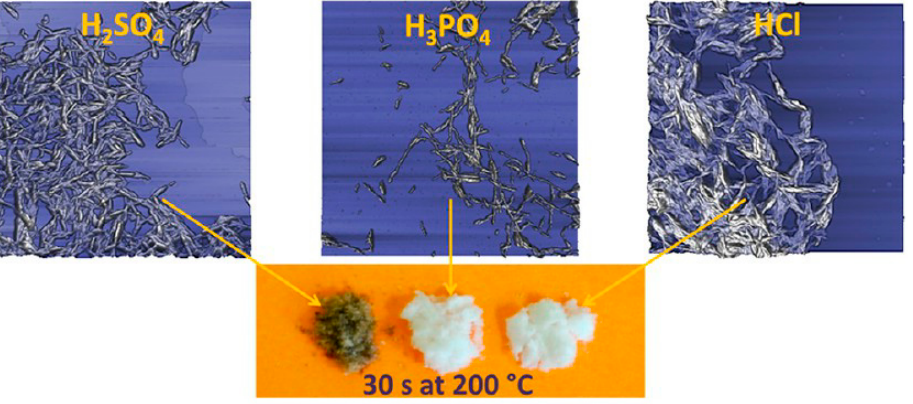
Figure 3. Schematic diagram of isolated CNCs by different acids. Reprinted from reference [67]. Copyright, 2013 American Chemical Society.